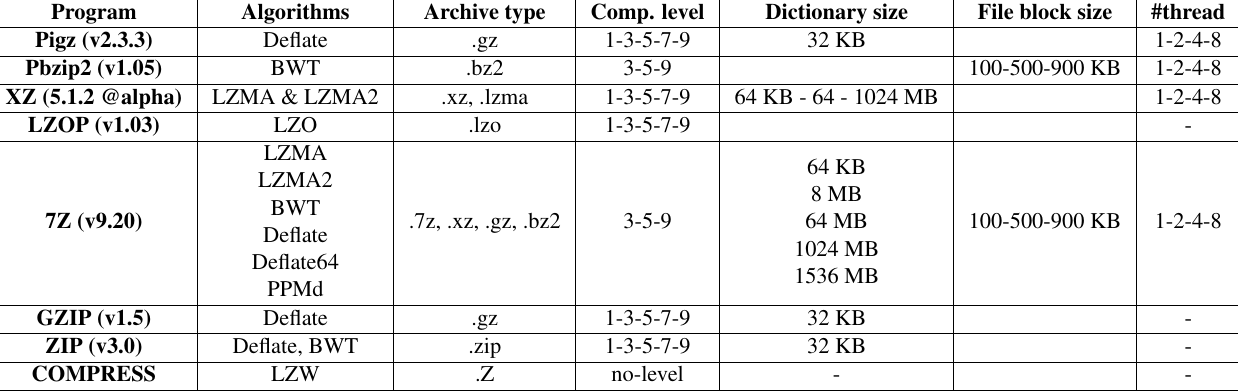
Table 2: Compression parameters for programs used.